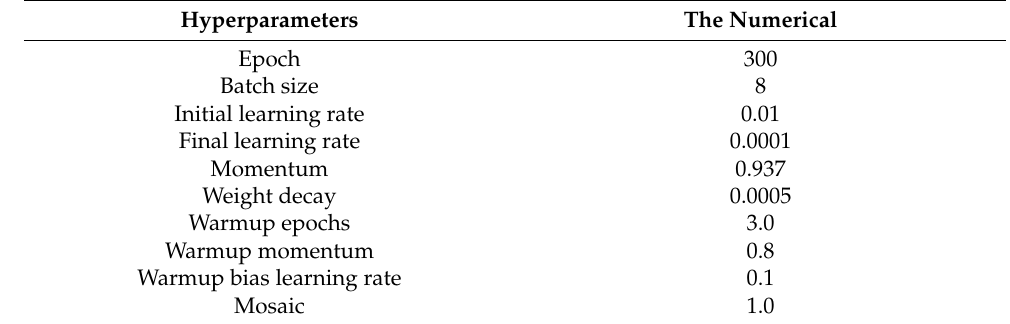
Table 2. Hyperparameters of the detection model. Hyperparameters The Numerical Epoch 300 Batch size 8 Initial learning rate 0.01 Final learning rate 0.0001 Momentum 0.937 Weight decay 0.0005 Warmup